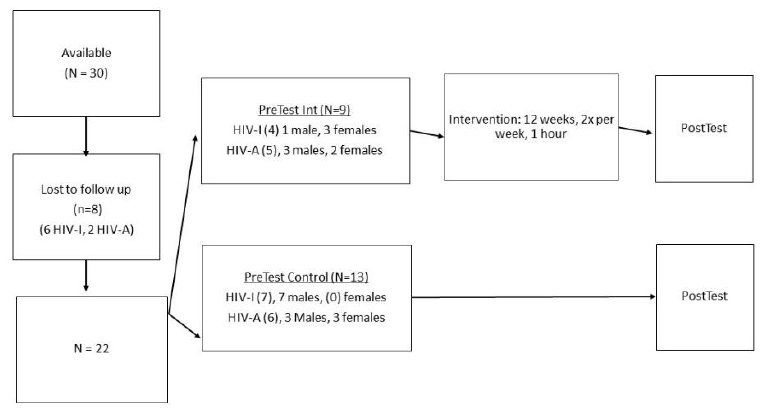
Figure 1. Flow diagram of research design.